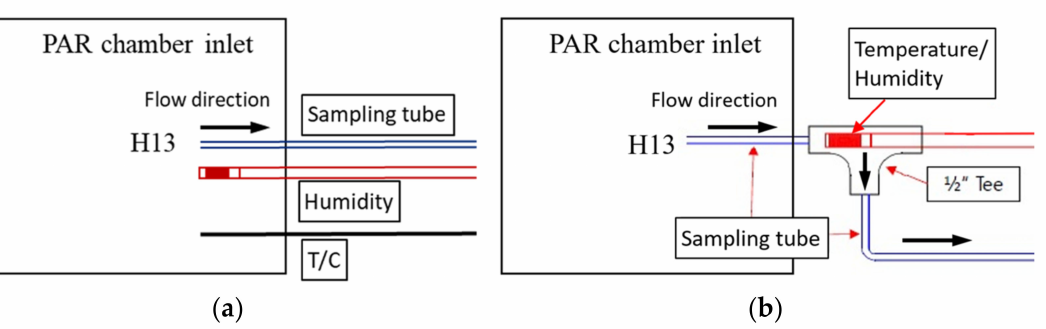
Figure 5. Schematics for measurement-system installations at PAR inlet: ( a ) generic installation; ( b ) revised installation to minimize thermal radiation effect.